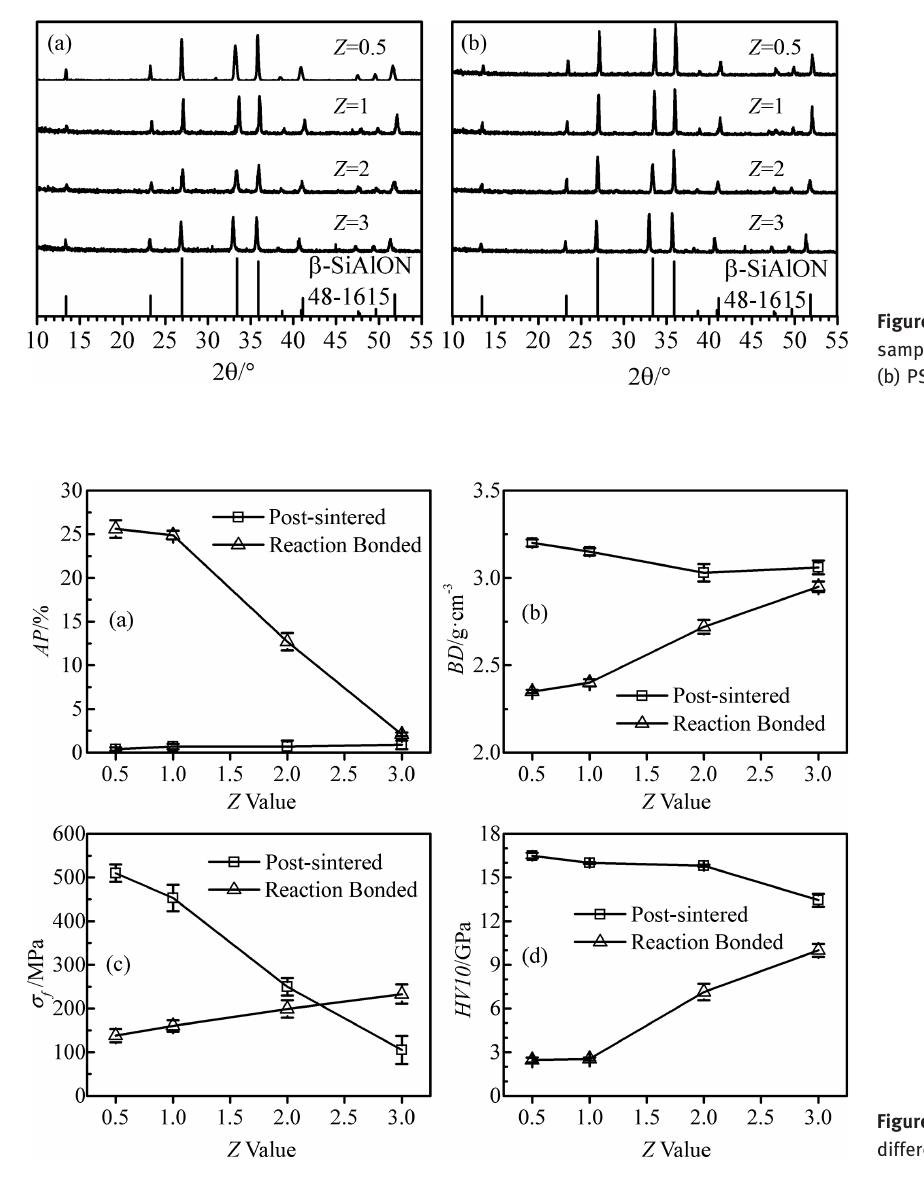
Figure 2: Properties of the samples with different Z